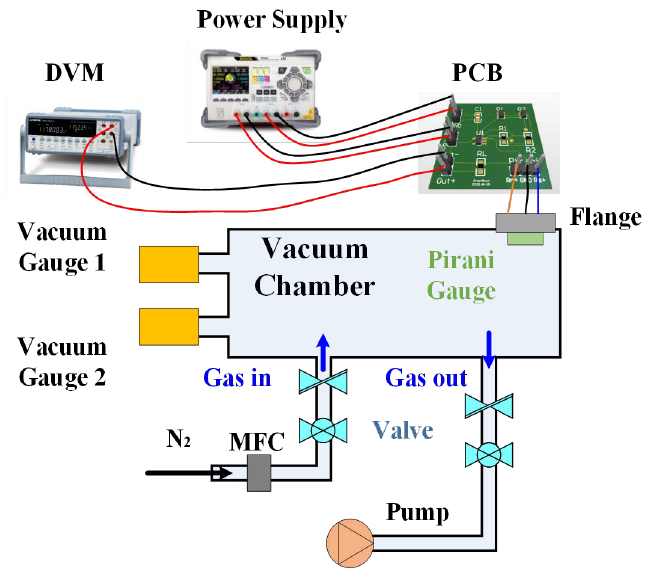
we used two vacuum gauges: an MKS Baratron capacitance manometer (627D12TDC1B) for low-pressure measurement and an Edwards active Pirani gauge (APGX-L-NW16 ST/ST) for high-pressure measurement.